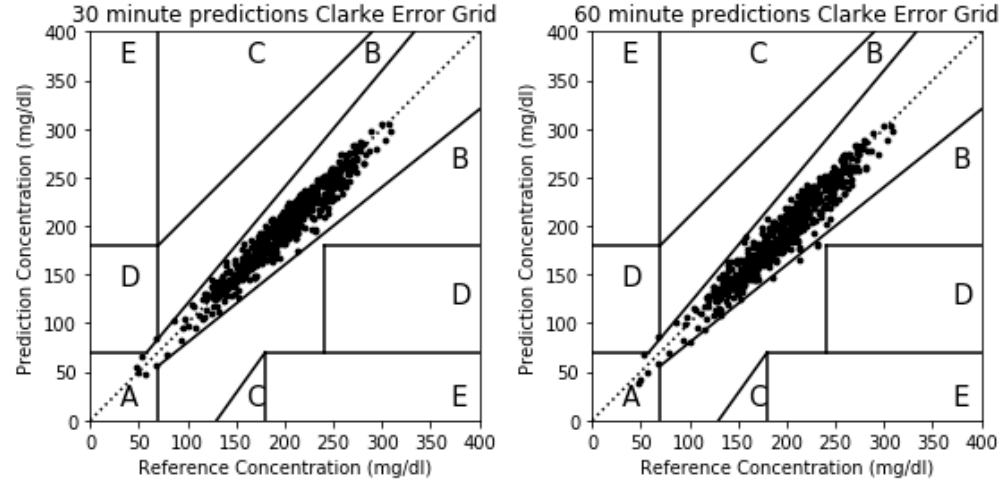
Figure 5. Clarke Error Grid for predictions on a 30 and 60 min horizon for a simulated participant.